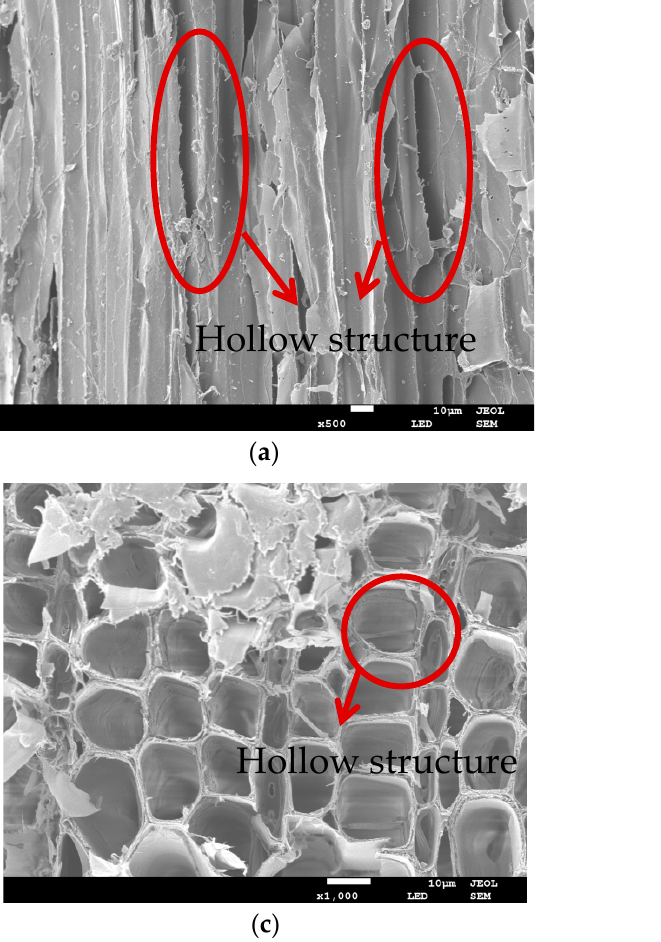
Figure 5. X-ray diffraction pattern of the hemp stalks.